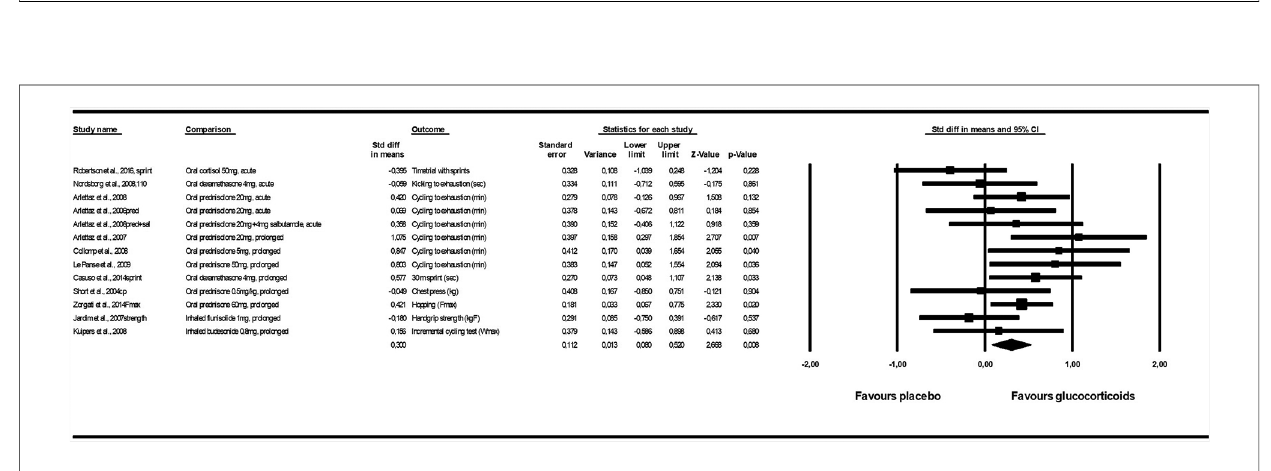
FIGURE 2 Funnel plot for the effect of glucocorticoids on maximal performance. The plot indicate no proclivity for publishing studies that found a signi fi cant effect of glucocorticoids.